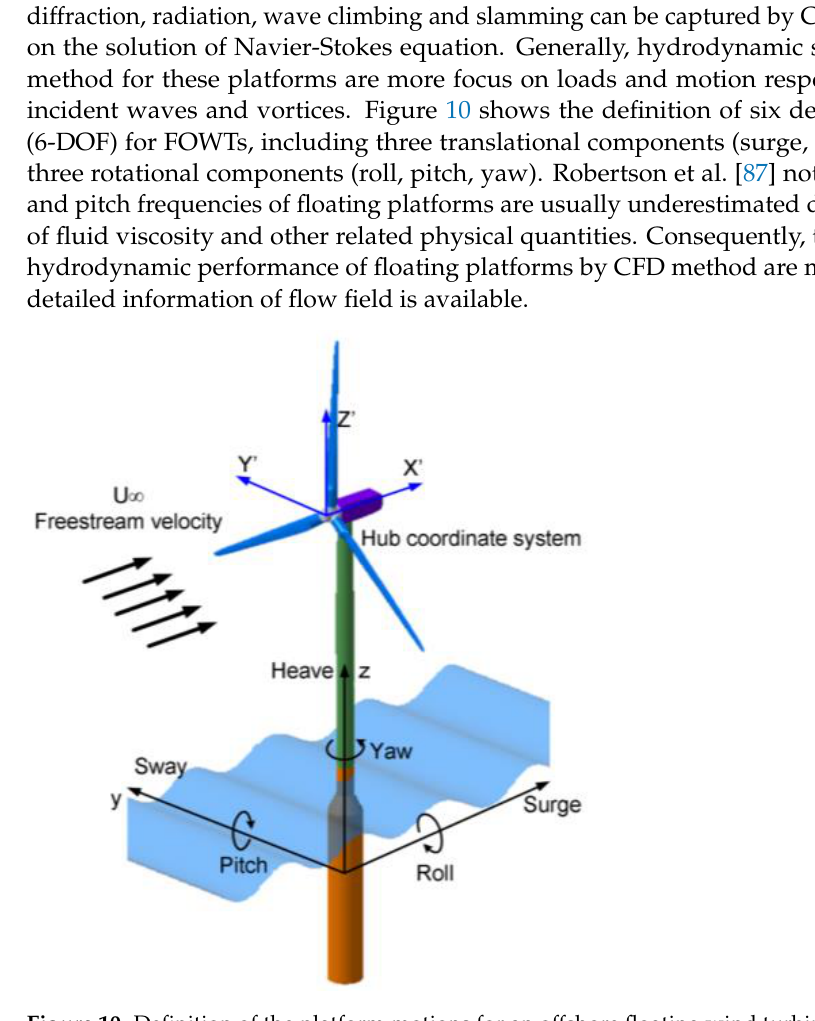
Figure 10. Definition of the platform motions for an offshore floating wind turbine [88]. Reproduced with permission from Tran et al., Journal of Mechanical Science and Technology; published by Springer Nature, 2015.